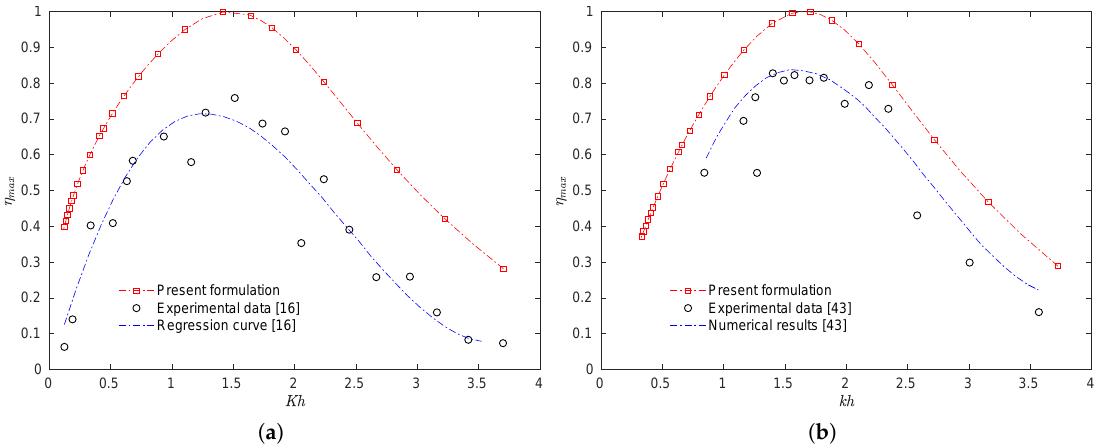
Figure 10. Hydrodynamic efficiency versus ( a ) Kh and ( b ) kh . ( a ) Comparison with experimental results obtained by Thomas et al. [16] for a thick front wall. ( b ) Comparison with experimental and numerical results obtained by Wang et al.